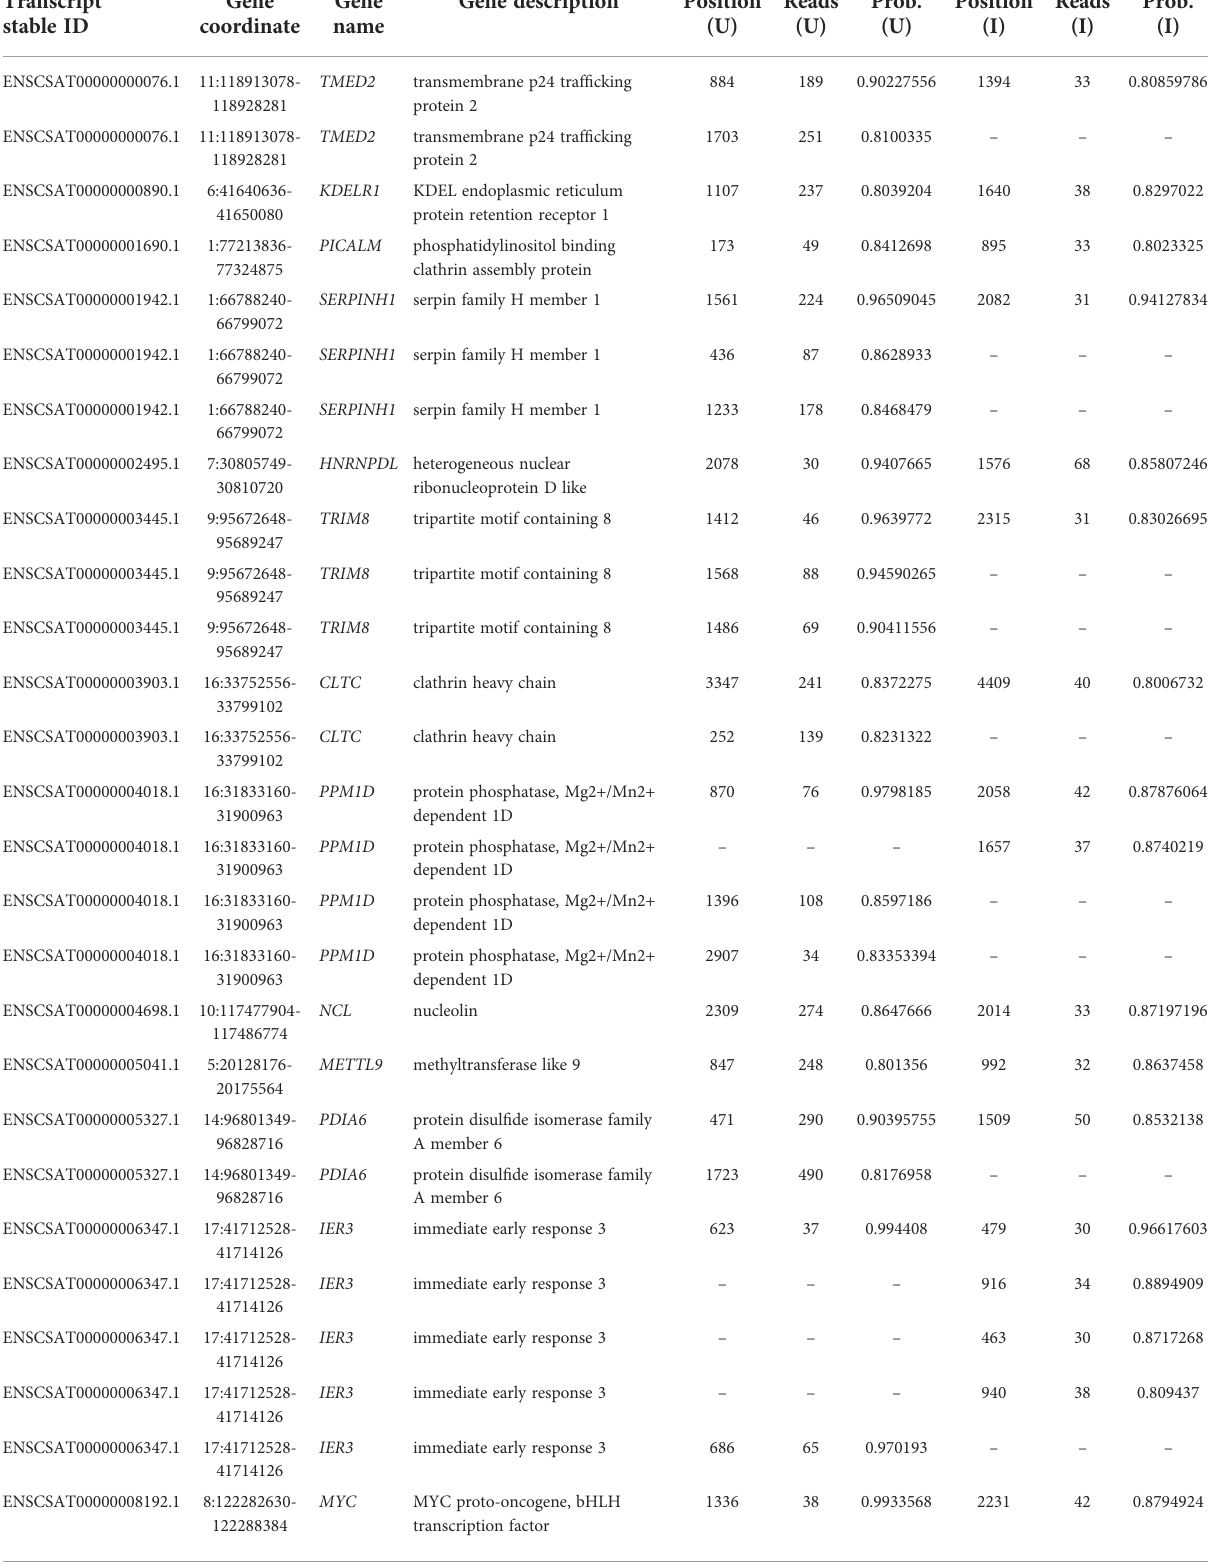
TABLE 3 Differentially methylated known genes obtained by comparison of uninfected cell (U) and infected cell (I) datasets from (Kim et al.,